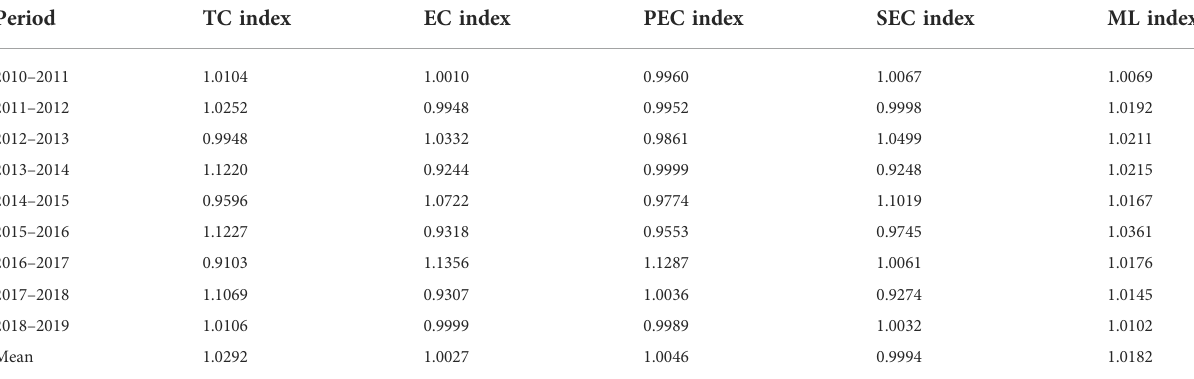
TABLE 5 The ML index decomposition results of PBCEE in 2010 – 2019.